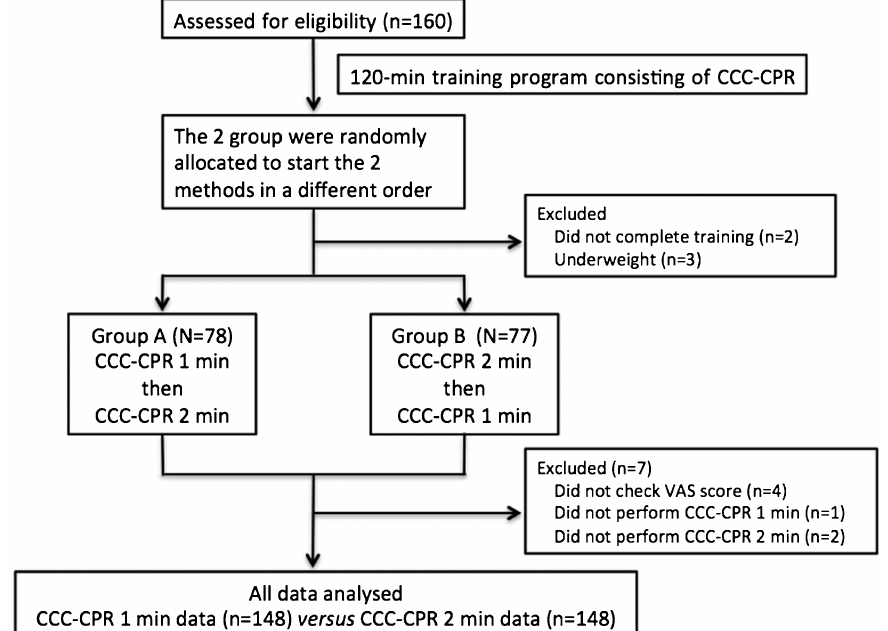
Figure 2 - Flow diagram of the